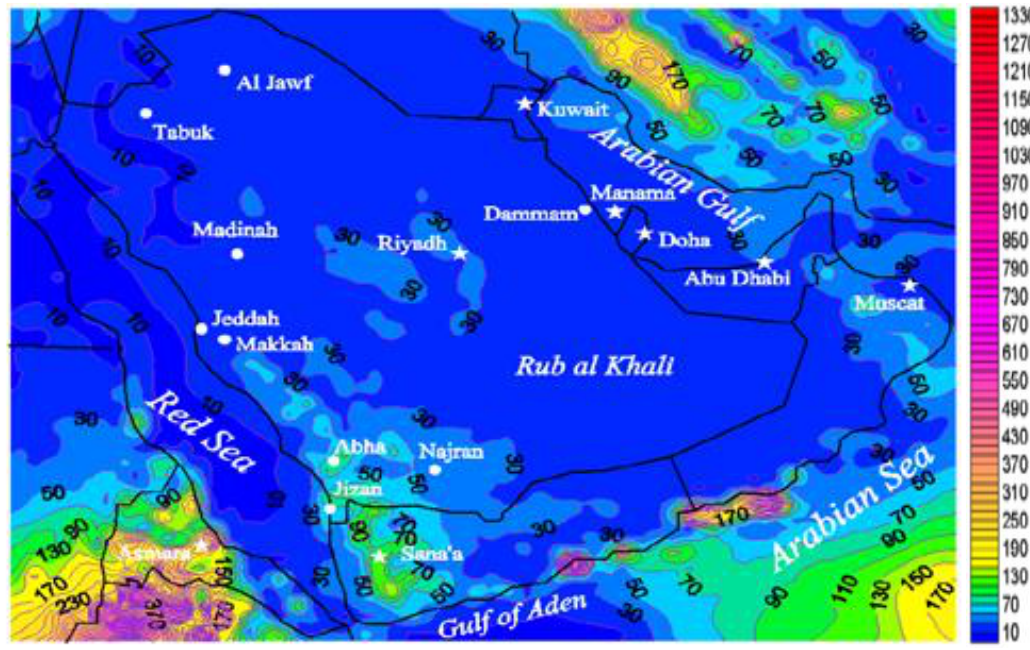
Figure 22. The spatial distribution pattern of the mean totalspring precipitation over the 2070–2100 period